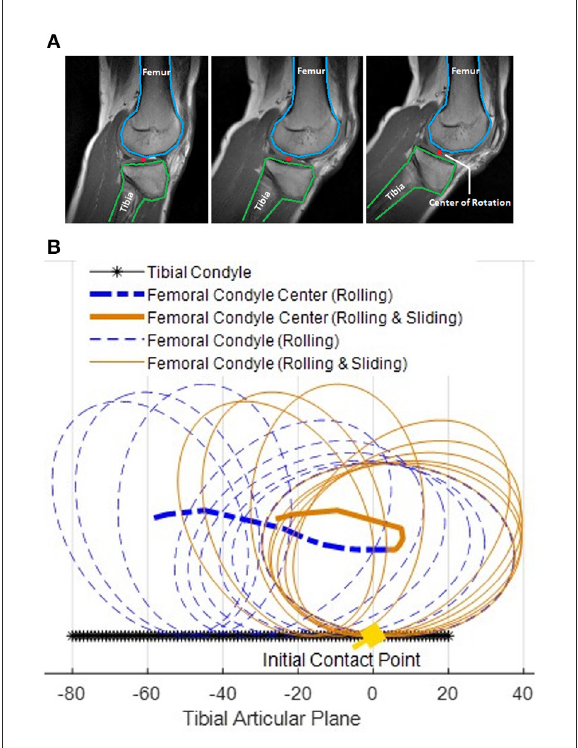
FIGURE2 (A) Magnetic resonance imaging (MRI) scanned for human knee joint when the knee joint is moving from extension (left) to flexion (right). The blue and green contours indicate the femur and the tibia, respectively. The red dot represents the knee joint center of rotation. (B) Simulation result of femoral condyle center during − 5 ◦ to 120 ◦ knee flexion movement using both pure rolling model (dotted blue lines) and rolling-sliding combined model (solid orange lines). Compared with the pure rolling femoral condyle center trajectory (bold dashed blue line), the rolling and sliding joint condyle center trajectory (bold solid orange line) allows the center of the femoral condyle to have smaller locomotion at the tibial articular plane with respect to the tibia (black line). The result indicates a non-fixed axis robot knee joint can mitigate misalignment compared with a traditional axis fixed robot knee rolling joint.